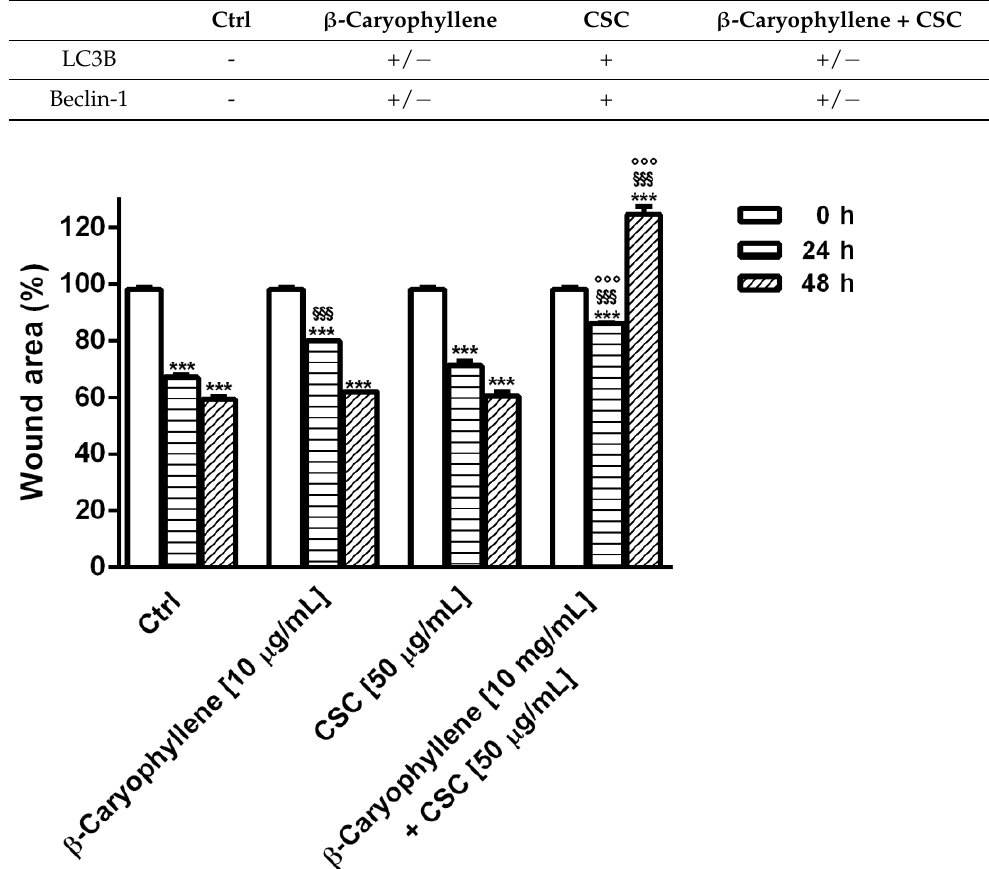
Table 4. Semiquantitative analysis of LC3B and Beclin-1 expression induced by β -caryophyllene and cigarette smoke condensate (CSC) in MDA-MB-468 cancer cells after 24 h exposure. Analysis has been carried out (five fields for each treatment) using a previous published grading system [42]: 0–5% = negative; 6–10% = +/ − ; 11–30% = +; 31–60% = ++; >61% = +++.